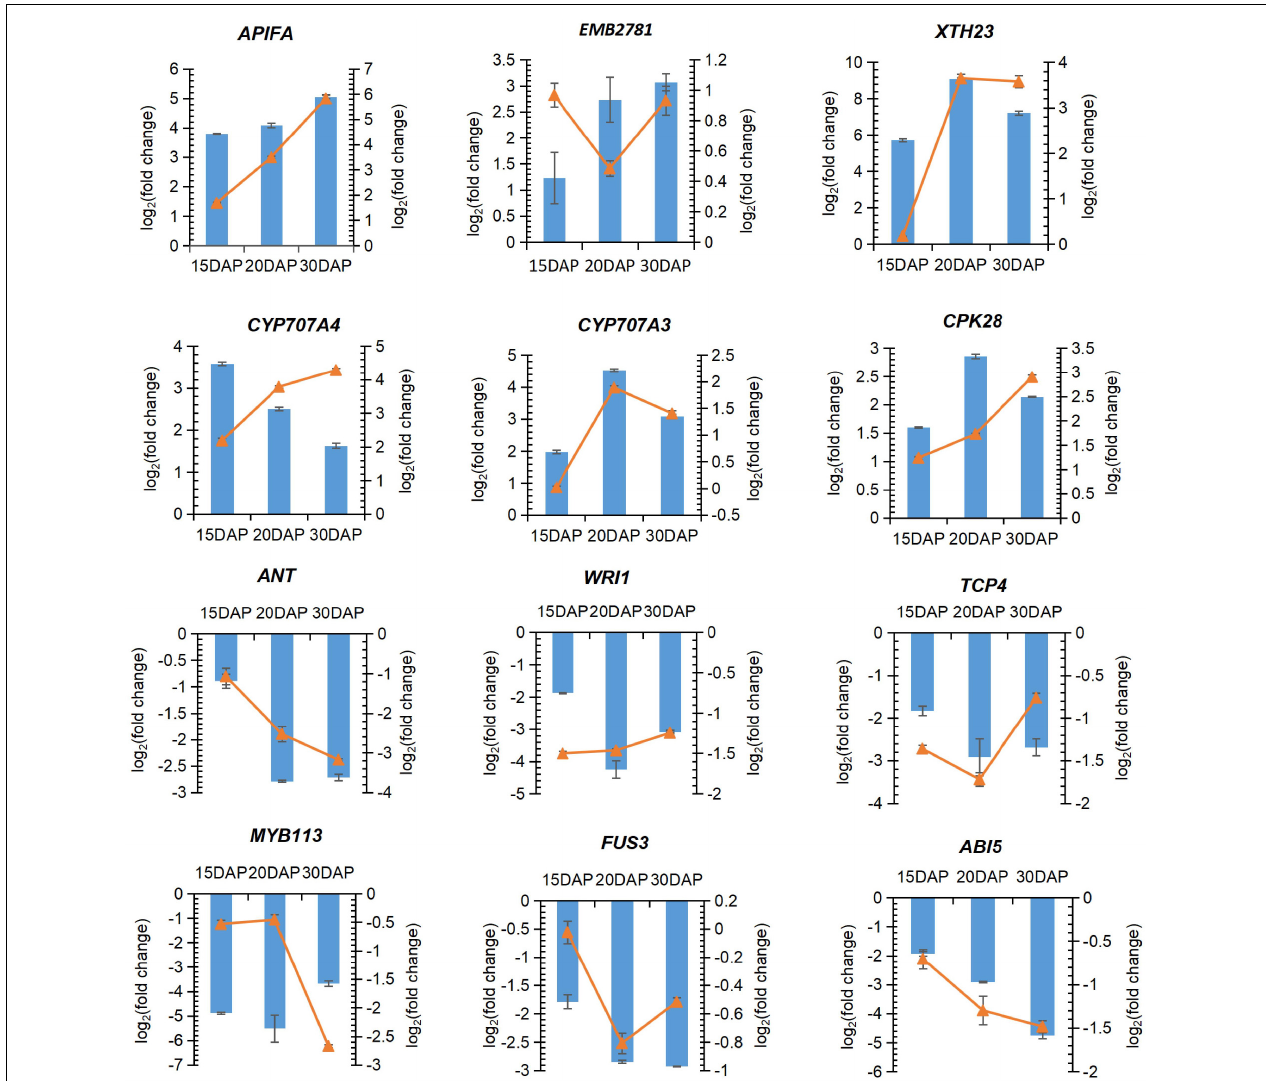
FIGURE 6 | Quantitative RT-PCR validation of selected DEGs under calcium deficiency and sufficiency in peanut embryo at 15, 20 and 30 DAP. Blue bar represents relative expression level changes calculated by the FPKM using RNA-seq. Orange line with indicates relative expression level changes determined by qRT-PCR